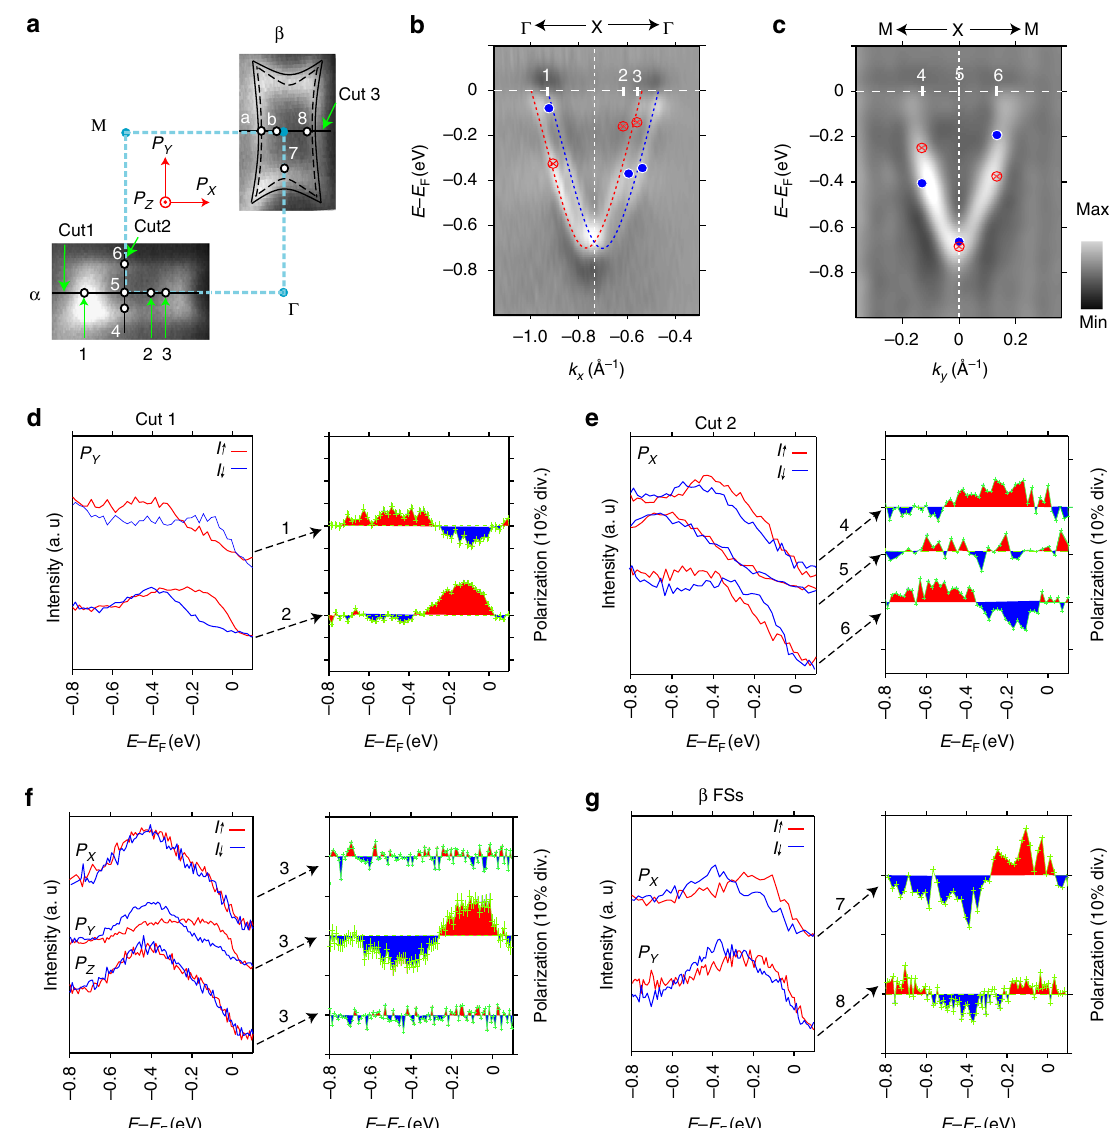
Fig. 2 Spin- and angle-resolved photoemission spectroscopy (SARPES) of lowest conduction band (LCB). a Fermi surface sheets (FSs) labeled α and β of LCB measured by using photon energy of 18 eV and the comparison with FSs of DFT calculation (black lines). The constant energy contour (CEC) maps are integrated over a window of ± 20 meV. The dots around X point denote the momentum points where we performed spin measurements, the points 1 – 3 along cut 1 and the points 4 – 6 along cut 2 were also marked in b , c . Coordinate axes ( P X , P Y , P Z ) denote positive directions of spin vectors. b Band dispersion measured by ARPES ( h ν = 18 eV) along the cut 1 ( Γ – X – Γ line, second derivative). The dashed red and blue lines represent extracted positions from the energy distribution curves (EDCs) used for the estimation of Rashba parameter. c The same as b but along the cut 2 (M – X – M line, second derivative). d Spin-resolved EDCs of P Y and its spin polarization along cut 1. e The same as d but of P X along cut 2. The peak positions of spin-up and spin- down states along cut 1 and cut 2 are indicated in b and c by red crosses and blue dots. f The same as d but of P X , P Y and P Z at point 3. g The same as d but of P X at point 7 and P Y at point